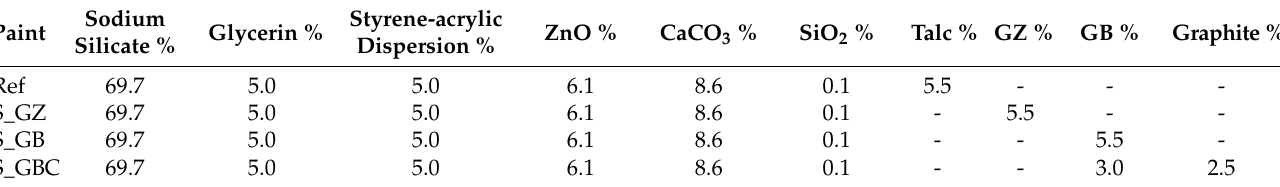
Table 1. Compositions of silicate paints with/without intumescent